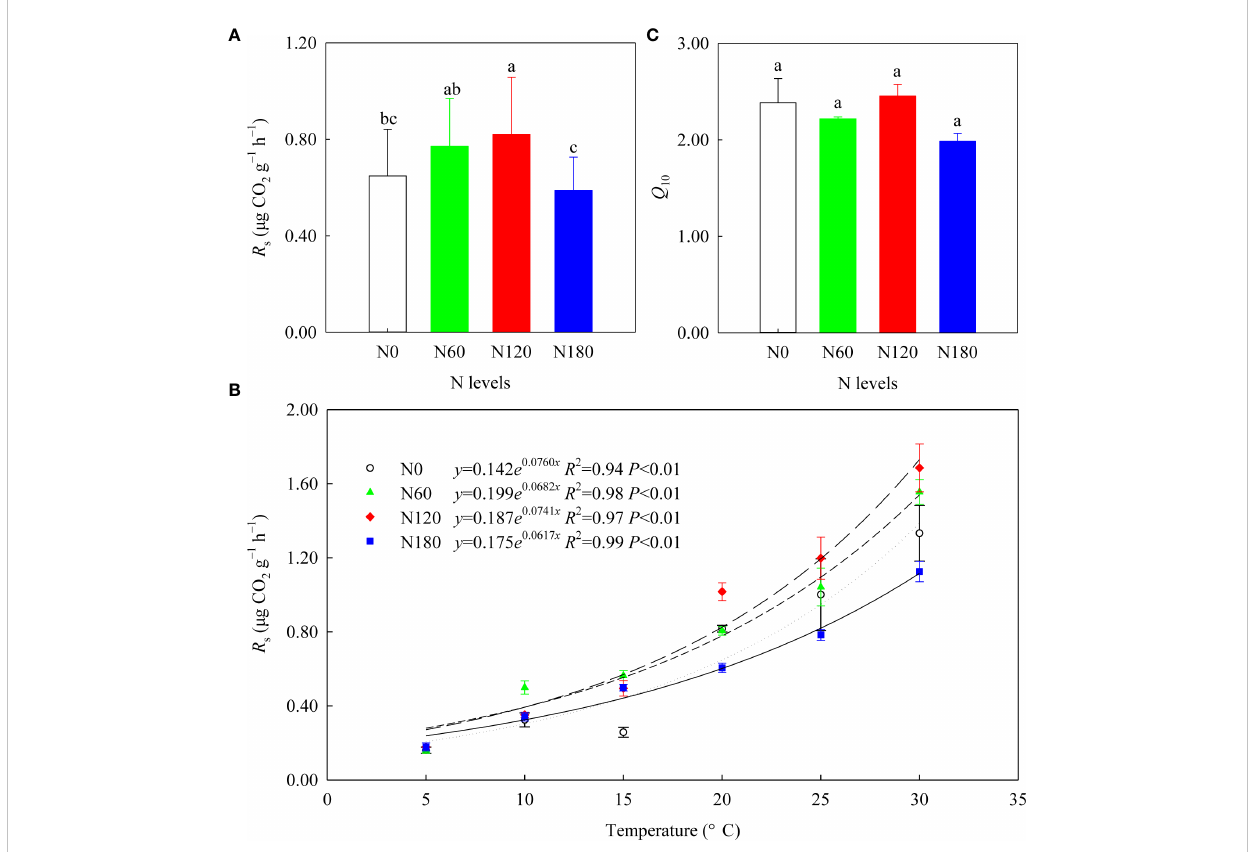
FIGURE 6 The soil respiration rates ( R s ) after averaging six temperatures (A) , the exponential growth curves between the mean R s and temperature (B) , and the mean Q 10 values (C) of the four treatments ( n =3). Different lowercase letters denote the difference among the N levels at P <0.05, ANOVA (±SE, n